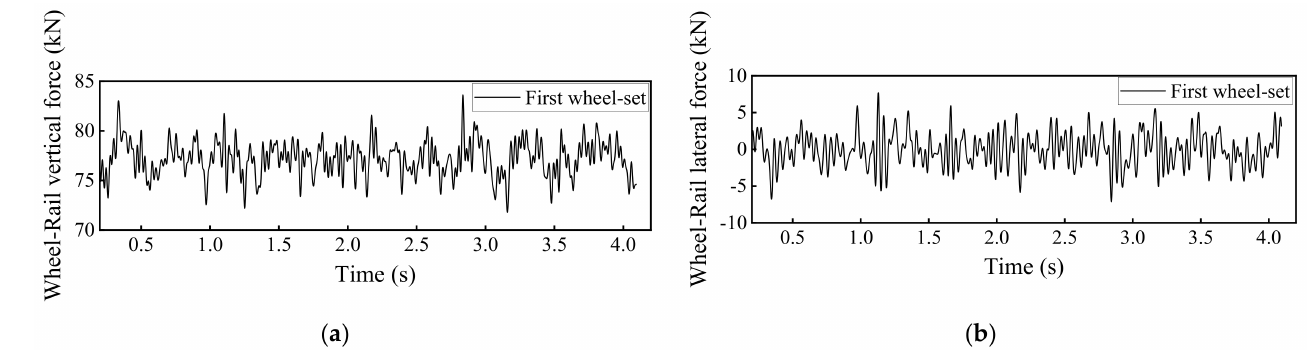
Figure 12. Model-calculated dynamic responses of the No. 25 sleeper: ( a ) Vertical acceleration and ( b ) vertical displacement.